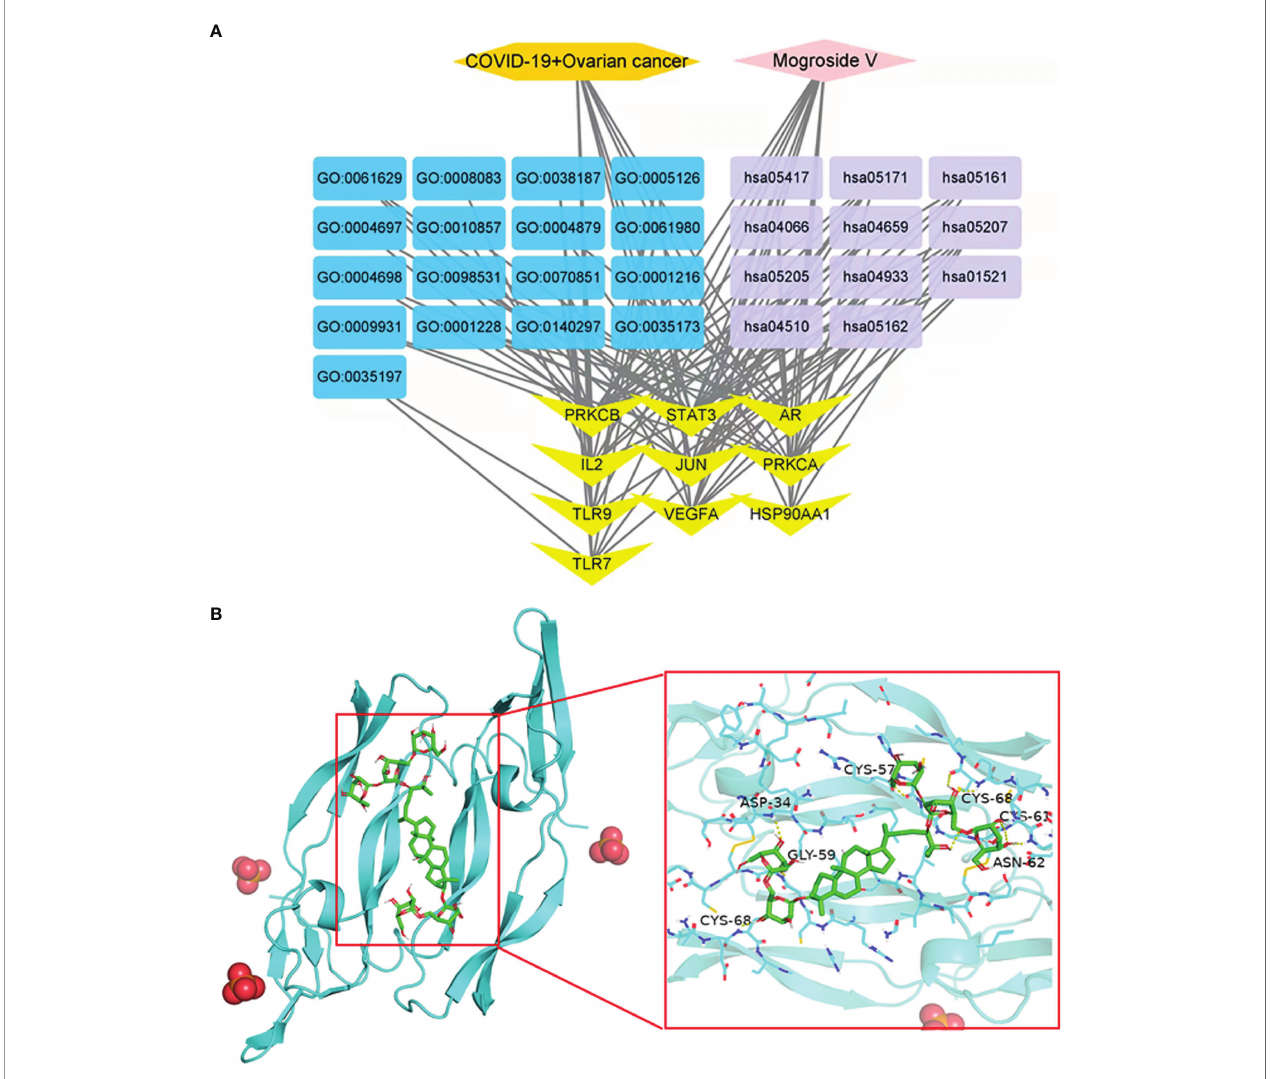
FIGURE 4 | Network diagram of mogroside V in COVID-19/ovarian cancer (A) . Molecular docking analysis of mogroside V with VEGFA. Mogroside V formed hydrogen bonds with CYS-68, ASP-34, CLY-59, CYS-57, CYS-68, CYS-61, and ASN-62 residues (B)